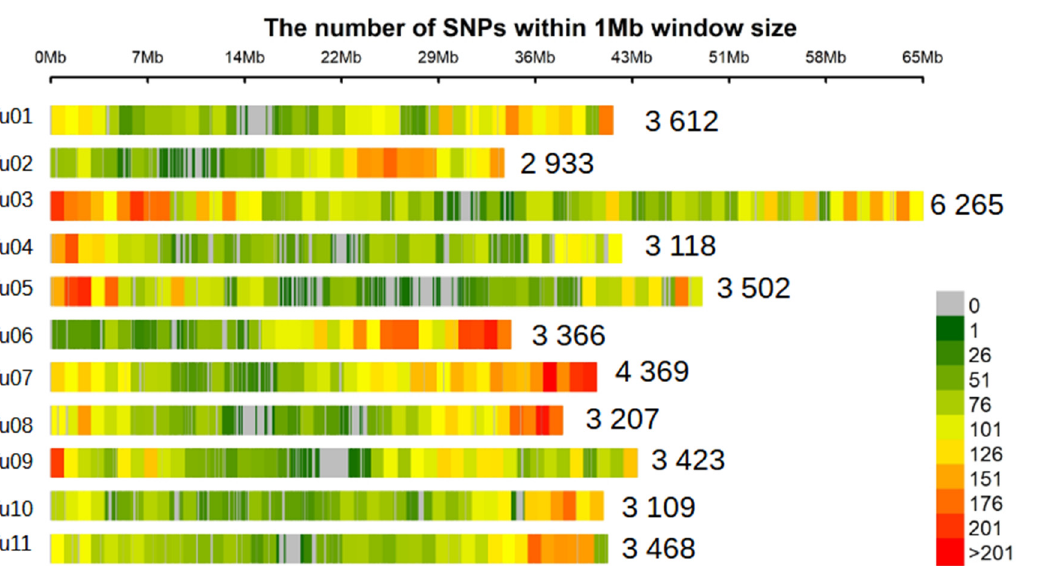
41.80 Abbreviations: CV = coefficient of variation; SE = standard error of mean; CD = critical difference between two means at 5% α level computed as [ √ (2EMS/b)] * (t 0.05,DFerror ), where b is the number of blocks and EMS is the error mean square; GCV = genotypic coefficient of variation; PCV = pheno- typic coefficient of variation; H 2BS = broad sense heritability; GA = genetic advance; GAM = genetic